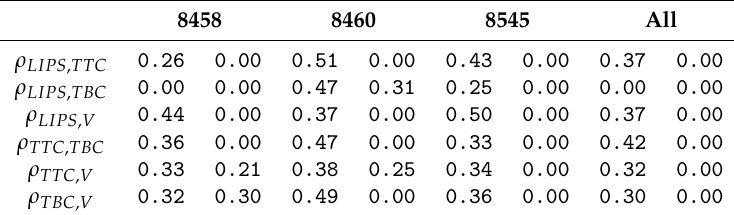
Tract variables for 2D correlation: LIPS : lips; TTC : tongue tip constriction TBC : tongue body constriction; V : velopharyngeal and orovelar